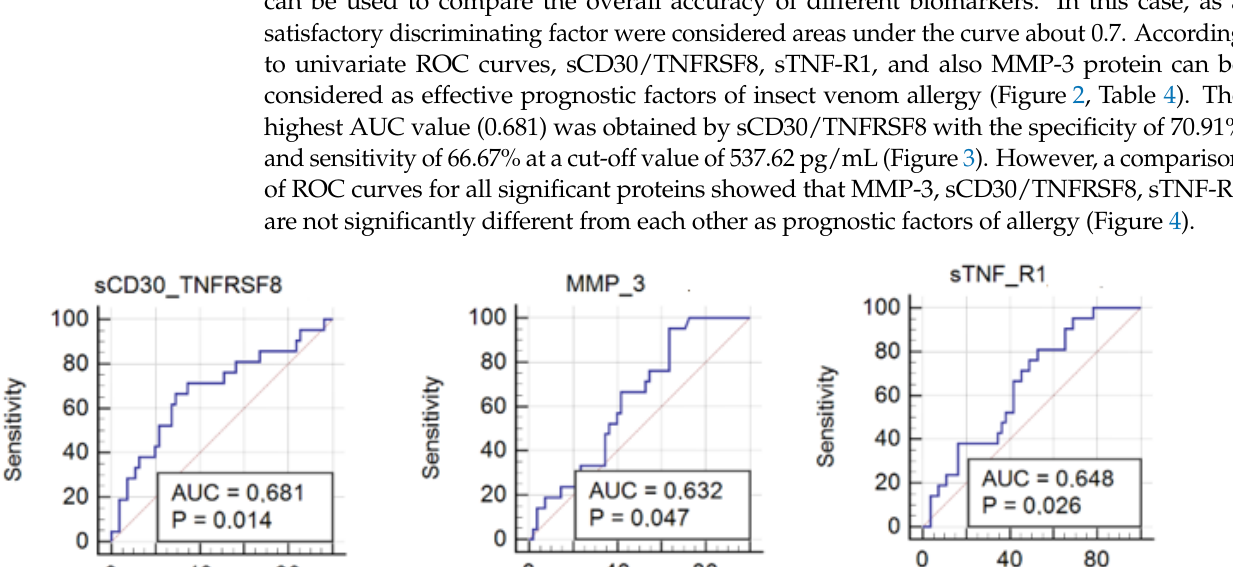
Figure 3. Box ‐ plot of the concentrations of sCD30/TNFRSF8 53 in both groups. A horizontal line is in red, indicating the optimal cut ‐ off. N—control group; Y—allergy group.